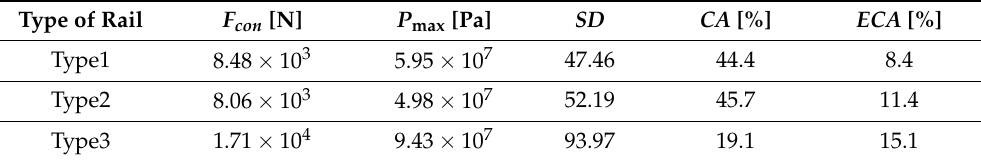
Table 1. Statistical results of initial contact parameters.